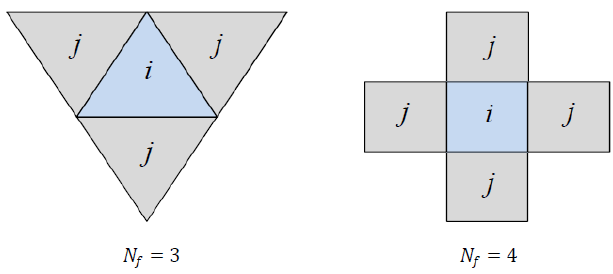
Figure 3. Two various element types surrounded by interfaces.